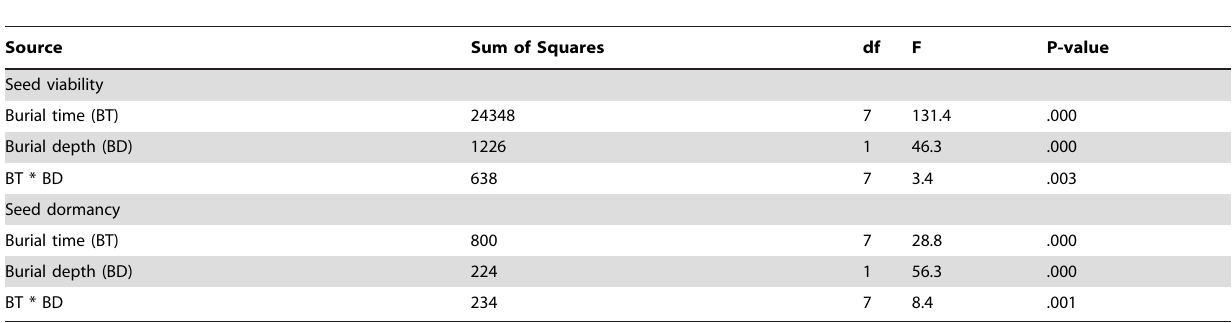
Table 3. Two way ANOVA of the effects of burial time, burial depth and their interaction on seed viability and seed dormancy of Stipa bungeana